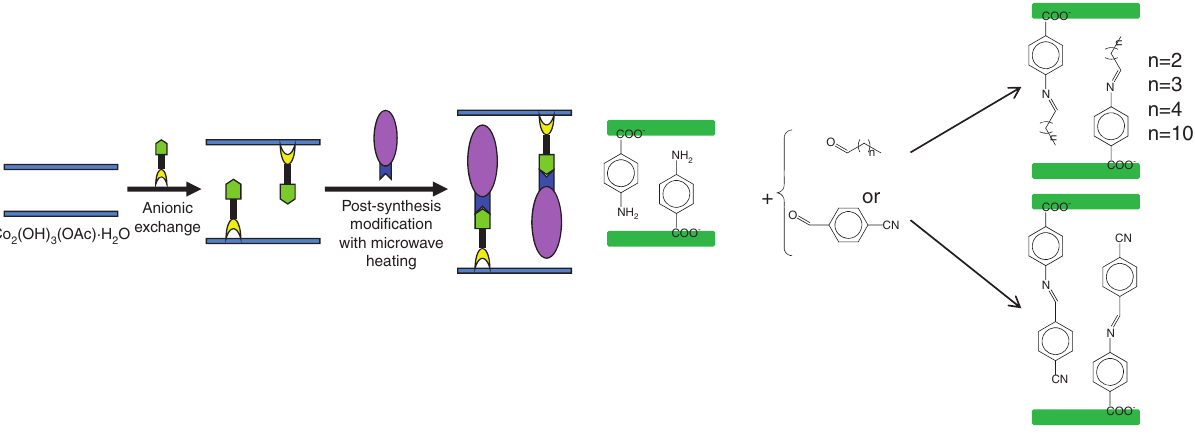
Figure 25: Scheme of the postsynthesis modification strategy in lamellar hydroxides (left) and specific examples obtained (right)